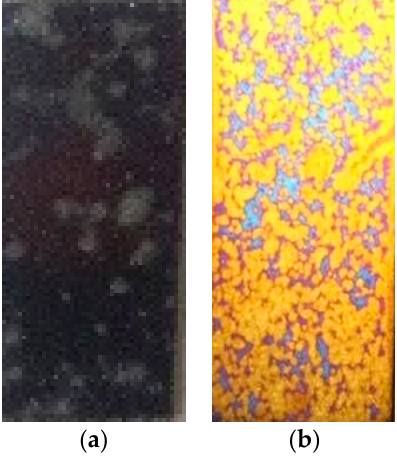
Figure 12. The hot corrosion surface after 88 h of ( a ) Ti-6Al-4V substrate and ( b ) TiN/ZrN coating.